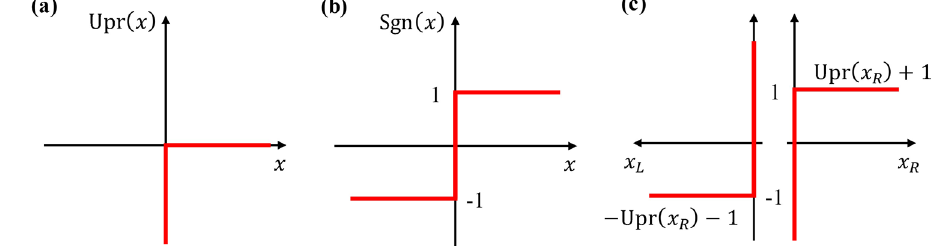
Fig. 1 Multifunction for com- plementarity: a Upr ; b Sgn ; c Decomposition of